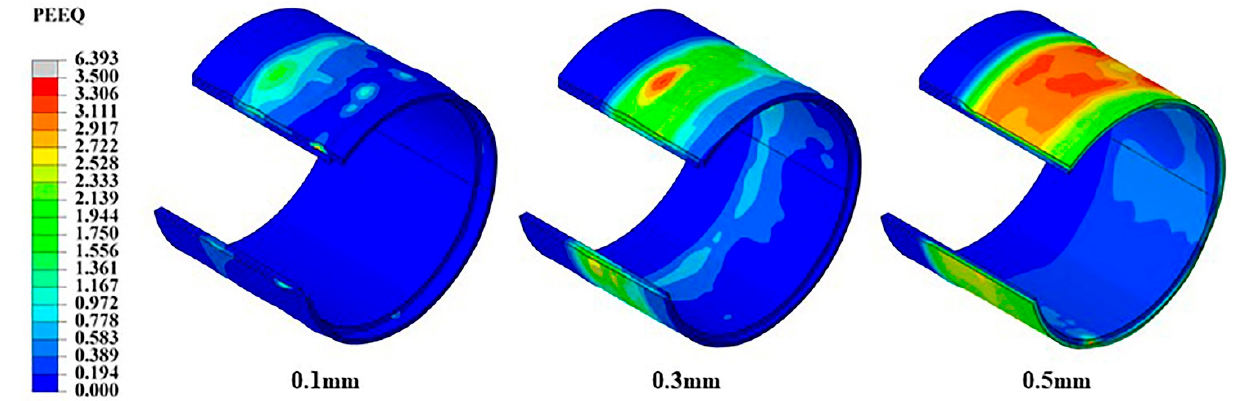
Figure 7. Simulated distribution of equivalent strain after rotary ring spinning with different press amounts.